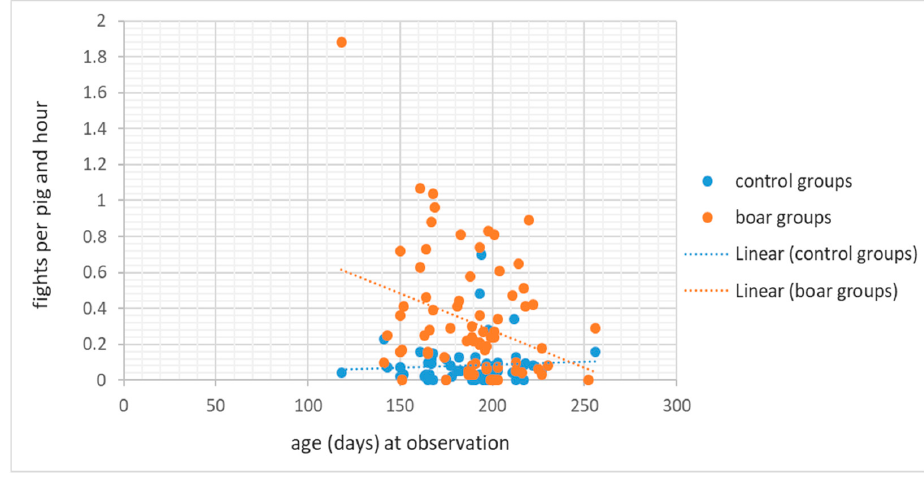
Figure 3. Significant interaction for frequency of fighting regarding the status of castration (boars vs. controls) and age.